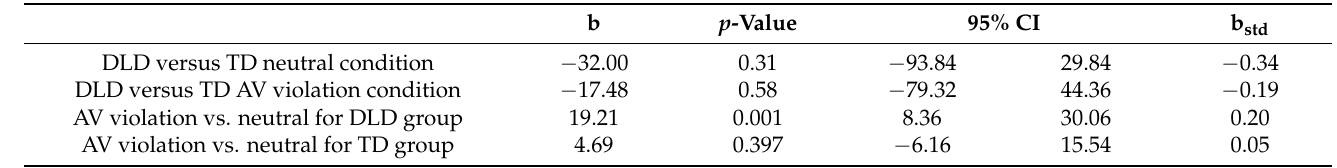
Table 5. Response time model simple effects for the group-by-condition interaction.